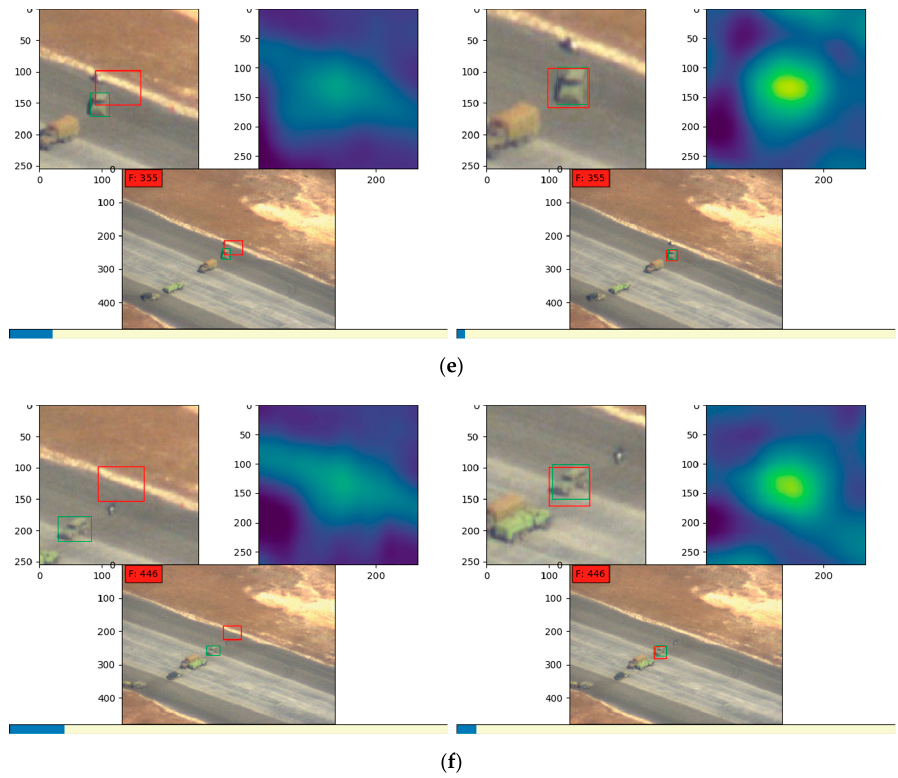
Figure 11. Results on images in datasets taken by the Defense Advanced Research Projects Agency (DARPA): ( a )–( f ) are six groups of comparison results on the DARPA dataset between the Siamese tracking methods without or with adaptive template-updating strategy. Bottom image in each group, tracking result in origin frame; top left, cropped image showing partial enlarged detail of tracking result; top right, corresponding heat map denoting similarity. Green boxes, ground truth; red, tracking results.